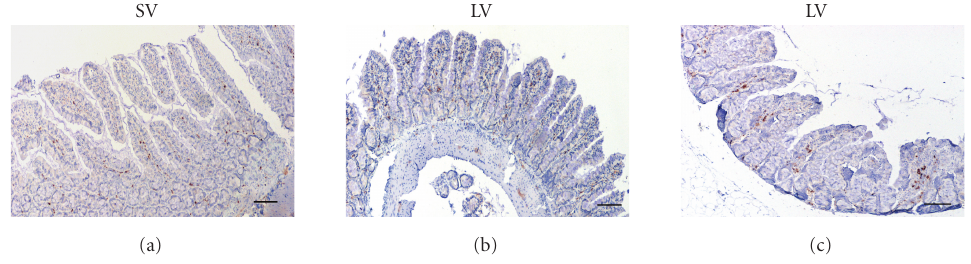
Figure 3: Expression of NF- κ B p50 in the small intestines in SV group (sham + vehicle, n = 6), LV group (lesion + vehicle, n = 6), and LP group (lesion + progesterone, n = 6). Very low NF- κ B p50 immunoreactivity was shown in the ileum tissue of the three groups (scar bar, 100 μ m).